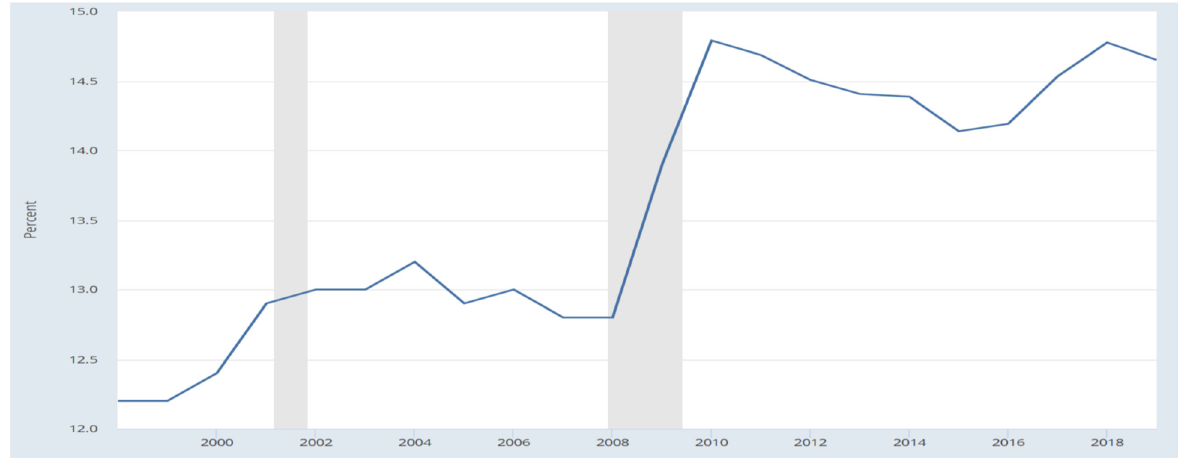
Figure 6. Bank Regulatory Capital to Risk-Weighted Assets (RWA). Source: World bank.